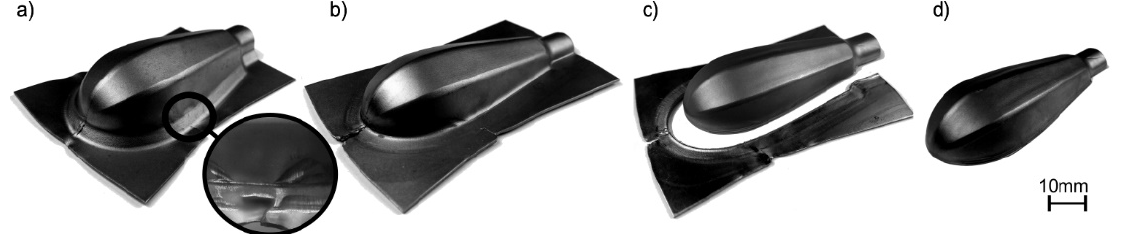
Figure 6. Subsequent stages of forming handle part from Grade 2 titanium sheet: ( a ) initial forming with magnification of wrinkling area; ( b ) supplementary forming; ( c ) trimming; ( d ) final forming.